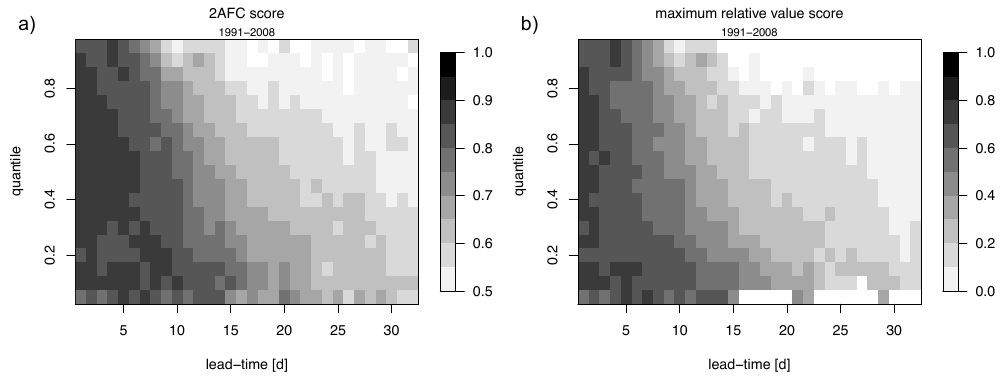
Fig. 4. 2AFC and maximum relative value scores for the Thur VarEPS/PREVAH daily mean runoff forecasts up to a lead time of 32 days. In the study period 1991–2008, probabilities of the ensemble forecasts to exceed different, quantile-based, varying thresholds are